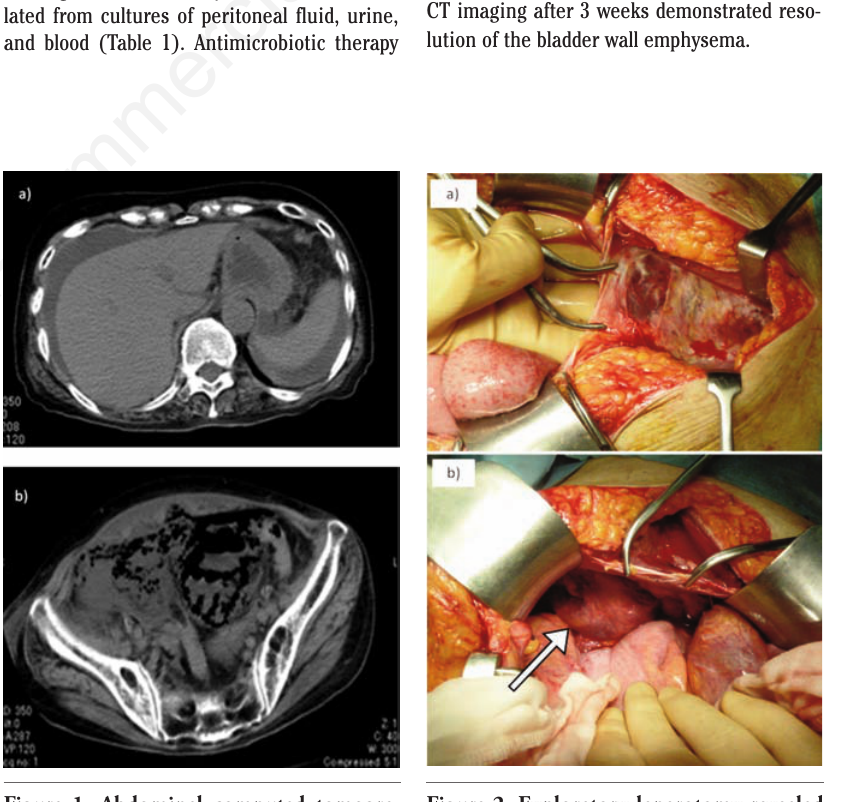
Figure 2. Exploratory laparotomy revealed inflamed peritoneum just below the umbilicus (a), and swollen bladder (b,